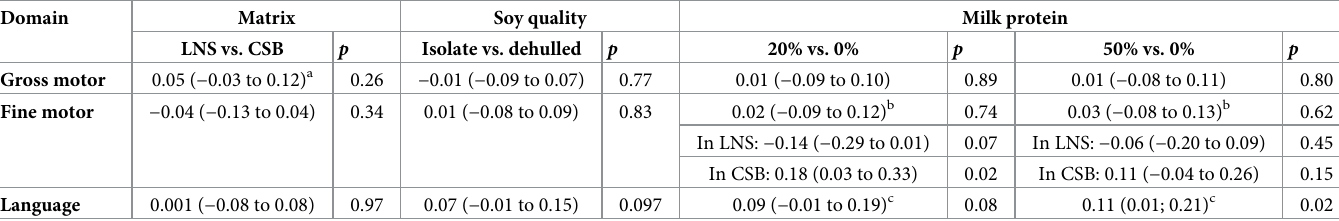
Table 3. Effects of supplementary foods on MDAT z-scores at end of intervention (12 weeks, n = 1,548). Domain